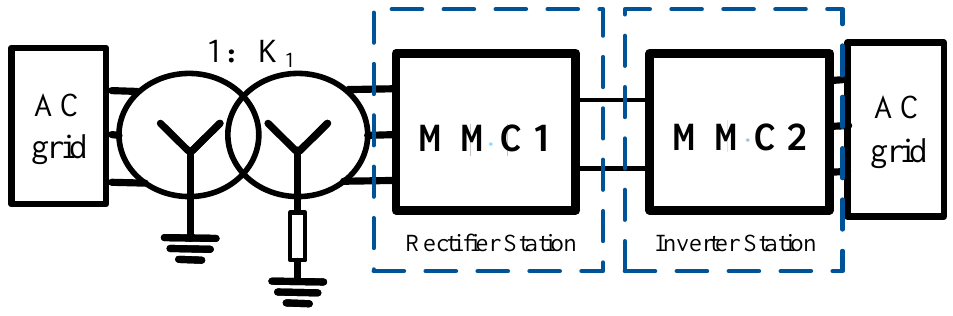
Figure 1. Structure of back-to-back MMC-HVDC system. During the open line test (OLT) of an actual back-to-back MMC-HVDC project in China, high-frequency harmonics appeared in system, and after the high-frequency harmonic suppression measures were optimized, other frequency resonance occurrences appeared, showing the continuous high-frequency oscillation phenomenon. Figure 2 shows the AC voltage waveform when the system oscillated for the first time. As shown in Figure 3, the dominant frequency of the harmonic is 1780 Hz and the amplitude is 0.11 pu. After the first high-frequency oscillation, a low-pass filter with a cut-off frequency of 400 Hz is added to the voltage feedforward of the control system to achieve oscillation suppression. However, in the other OLT test, oscillation reappeared in the back-to-back HVDC system and the AC system. The dominant frequency of harmonics was 700 Hz and the amplitude was 0.097 pu as shown in Figure